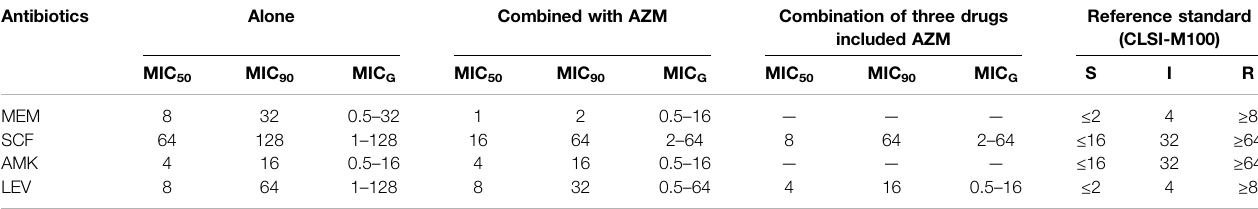
TABLE 5 | MIC values of MEM, SCF, AMK, and LEV single drugs or after being combined with AZM against the 25 isolates of MDR P. aeruginosa (ug/mL). Antibiotics